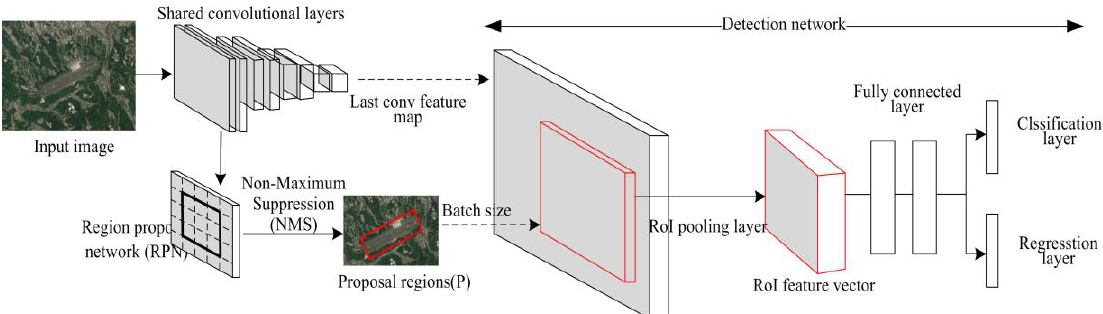
Figure 2. Schematic diagram of the Faster R-CNN.